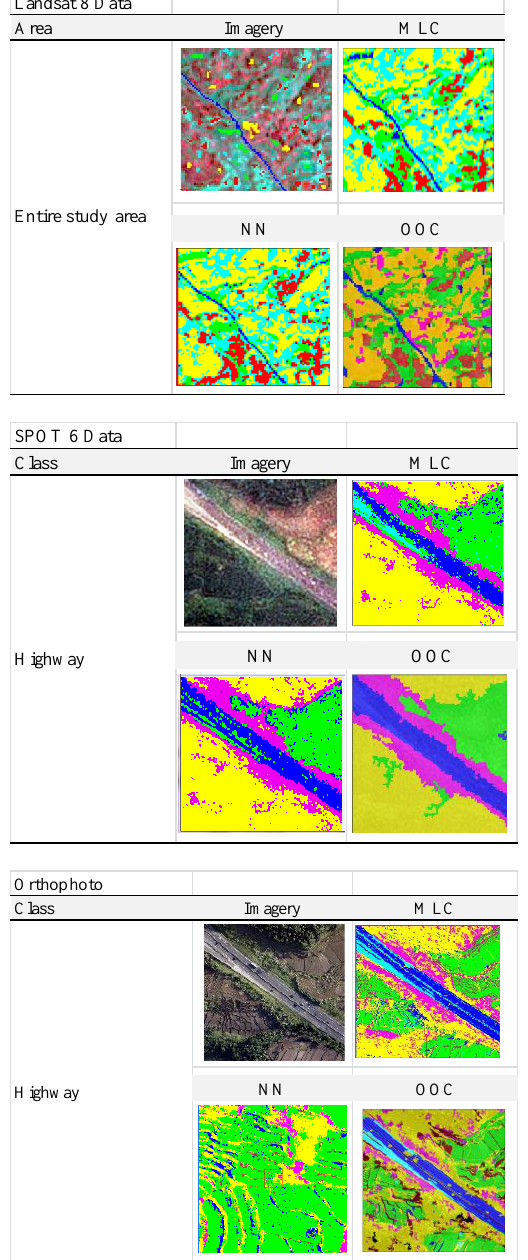
Table 9. Visualization classification results